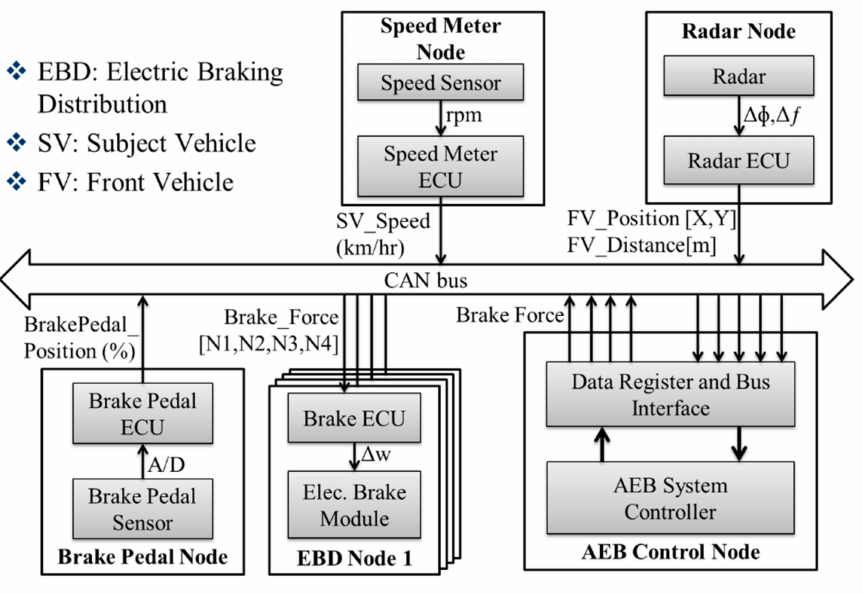
Figure 7. Hardware architecture of the AEB system.